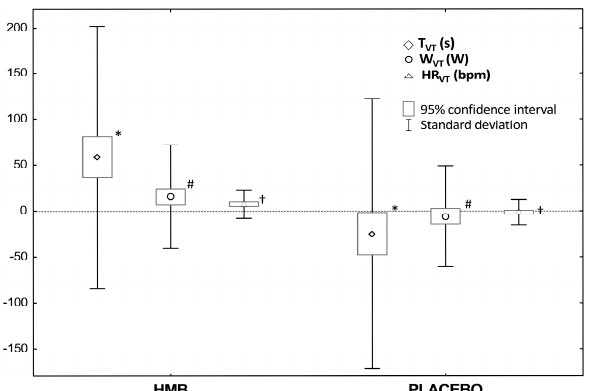
Figure 3. Changes in rates at ventilatory threshold after 12-week supplementation of HMB and placebo. Values are means ± SD and 95% CI. Abbreviations: HMB, β -hydroxy- β -methylbutyric acid; VT, ventilatory threshold; T VT , time to VT; W VT , load at VT; HR VT , heart rate at VT. Significant differences compared with placebo: * p < 0.0001 (dependent samples t -tests); # p = 0.017 (Wilcoxon rank-sum test); † p < 0.0001 (dependent samples t -tests).